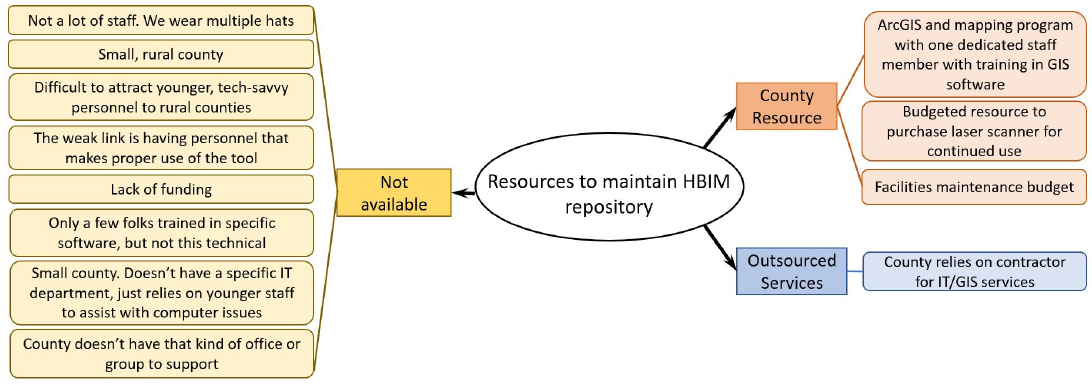
Figure 18. Results to interview question #8: resources to maintain a HBIM program.